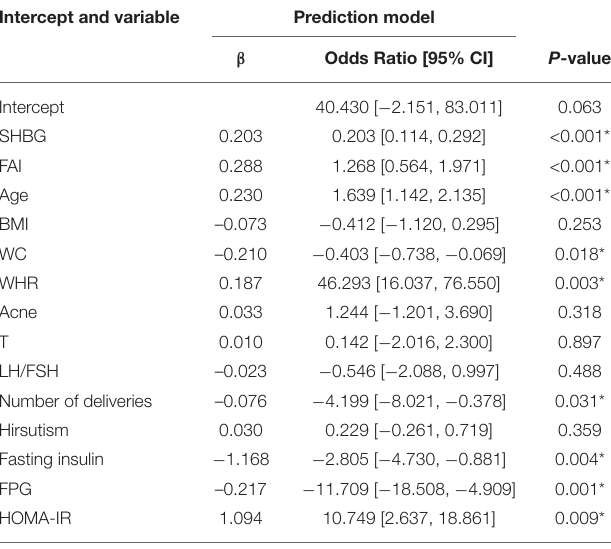
TABLE 3 | Linear regression analysis between SAS-SS and the clinical parameters of women with PCOS. Intercept and variable